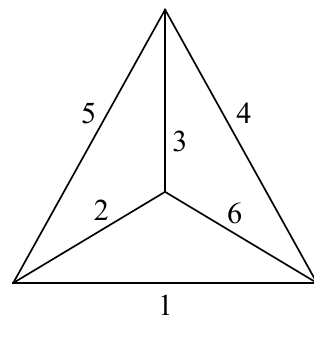
Figure 6. The 6 j symbol, represented as a